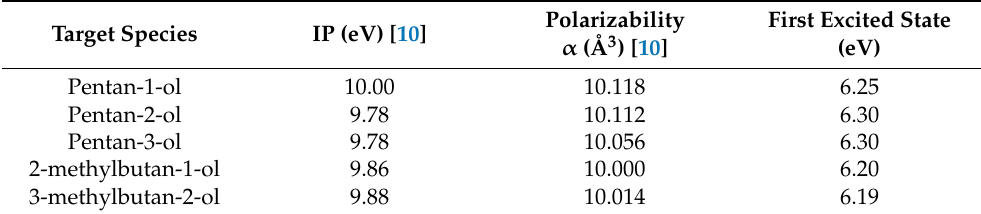
Table 2. Target properties (pentanol isomers).